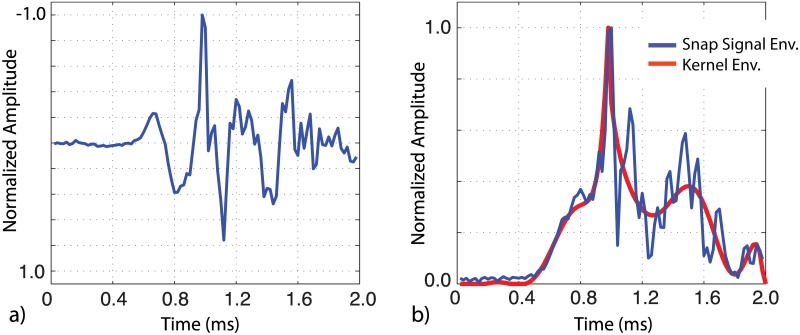
Snap detection using envelope correlation.a) Band-pass filtered (1.5–20 kHz) waveform showing an individual snap. b) The envelope of the snap waveform (blue) and kernel (red). The detection score (correlation) between the signal envelope and kernel is 0.85, sufficient to declare detection.